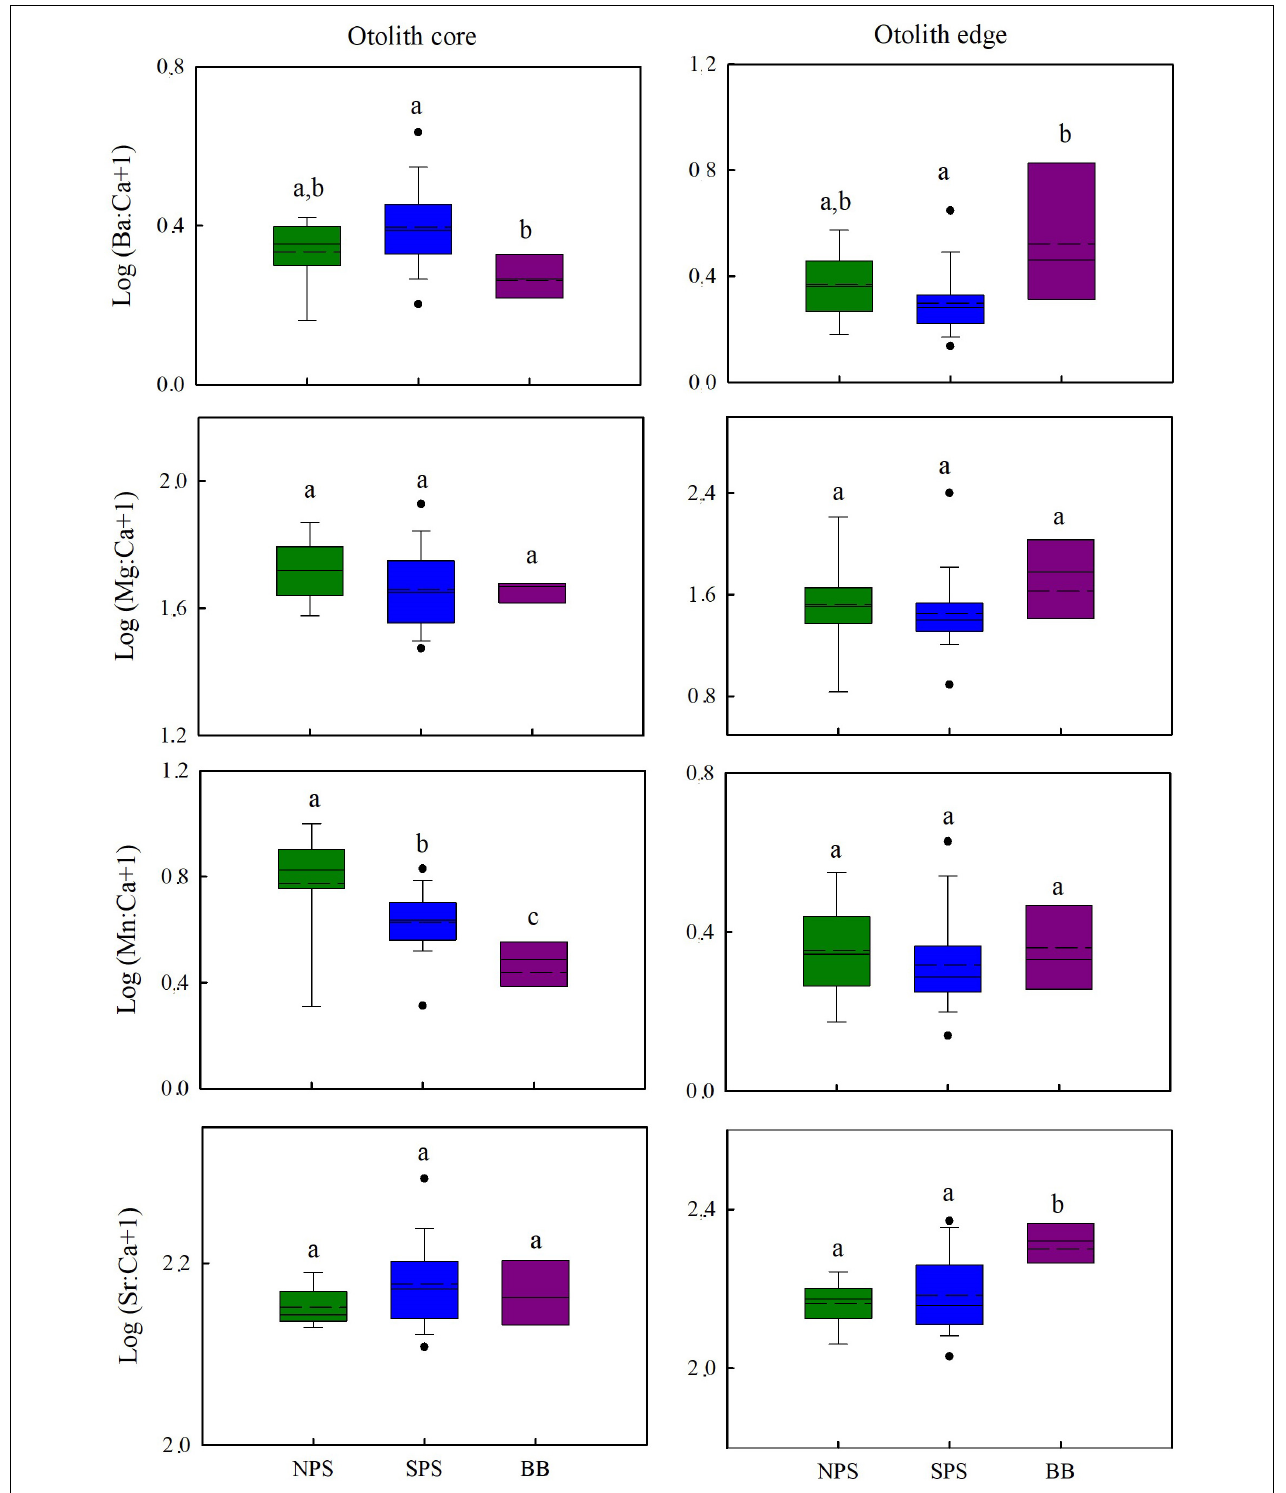
FIGURE 3 | Box plots showing the mean (dashed line), the median (solid line) and 25th and 75th percentiles of Ba:Ca, Mg:Ca, Mn:Ca, and Sr:Ca ratios for otolith core and edge areas of C. trigloides from the southwestern Atlantic Ocean. Different letters indicate significant differences among geographic areas. BB, Burdwood Bank; NPS, northern Patagonia shelf; SPS, southern Patagonia